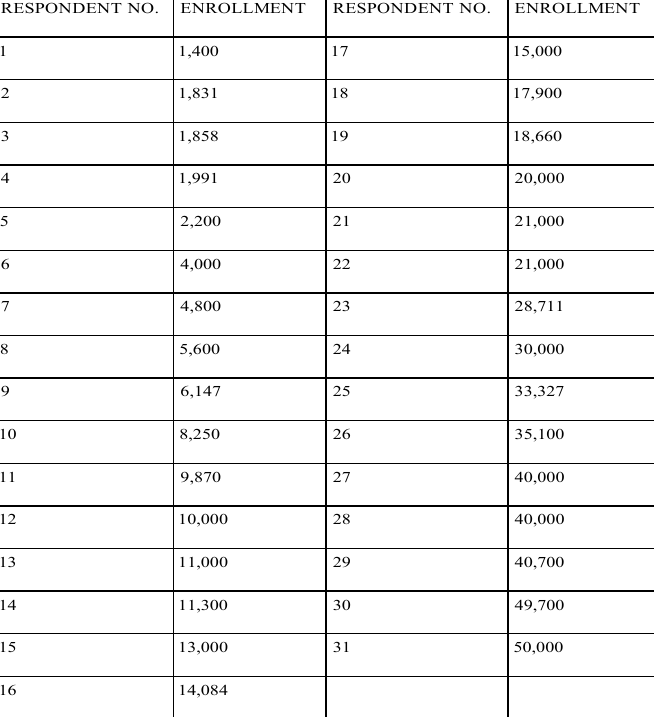
.ONTNEDNOPSER TNEMLLORNE